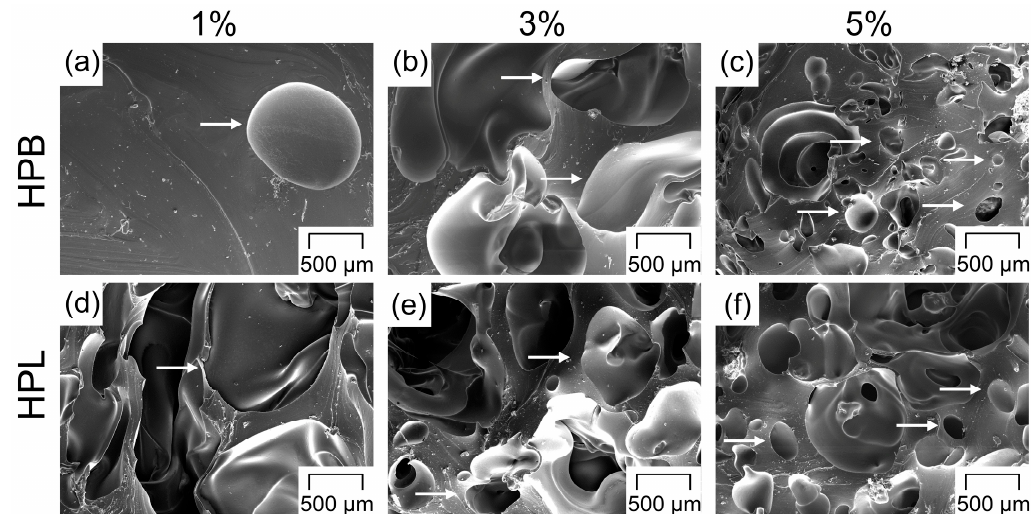
Figure 4. Scanning electron microscopy (SEM) images of the cryofractured surface of the extrudates as a function of the pore former concentration for ( a – c ) hydrophobic (HPB) and ( d – f ) hydrophilic thermoplastic polyurethane (HPL). The white arrows mark the introduced pores.